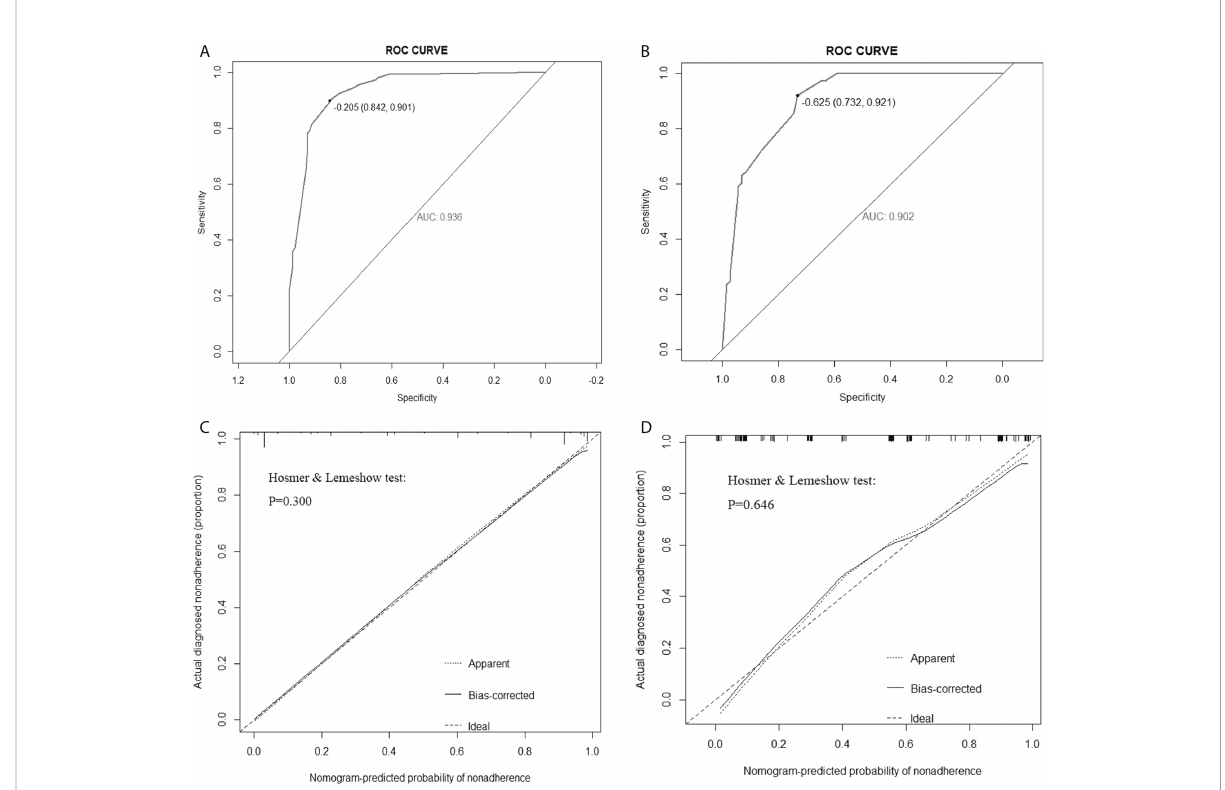
FIGURE 4 Receiver operating characteristic (ROC) curves of the nomogram in the training set (A) and validation set ( B ). Calibration curves of the nomogram in the training (C) and validation (D) sets. The ideal prediction is represented by the diagonal dashed line, whereas the performance of the nomogram is represented by the solid line. A dashed line closer to the diagonal one suggests a more accurate prediction. AUC: area under the curve.